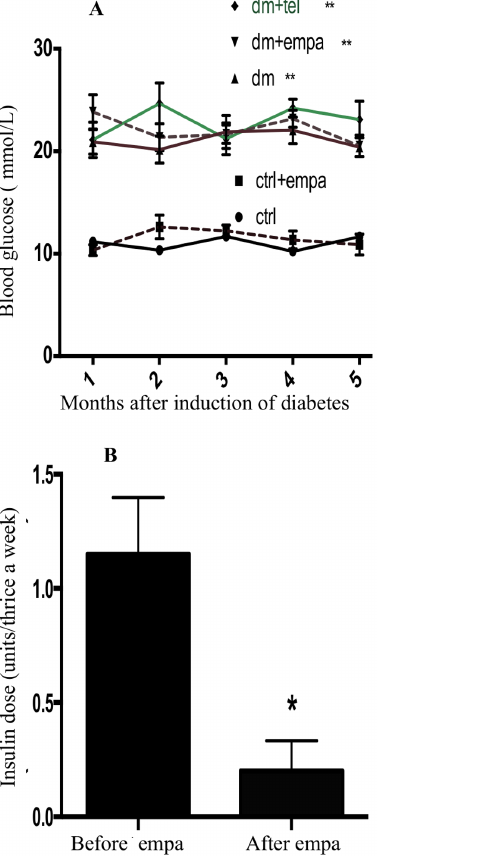
Figure 1. Blood glucose levels among diabetic mice were matched throughout the study and showed similar glucose levels among the diabetic mice at 1, 2, 3, 4 and 5 months post diabetes induction and were significantly higher than control mice (A). Empagliflozin reduced insulin requirement in diabetic mice (B). The comparison was made between average insulin requirement per dose administered thrice weekly, before and after initiation of empagliflozin. Data are expressed as mean 6 SEM with *=P , 0.05 and **=P , 0.001 vs ctrl. doi:10.1371/journal.pone.0108994.g001 PLOS ONE |